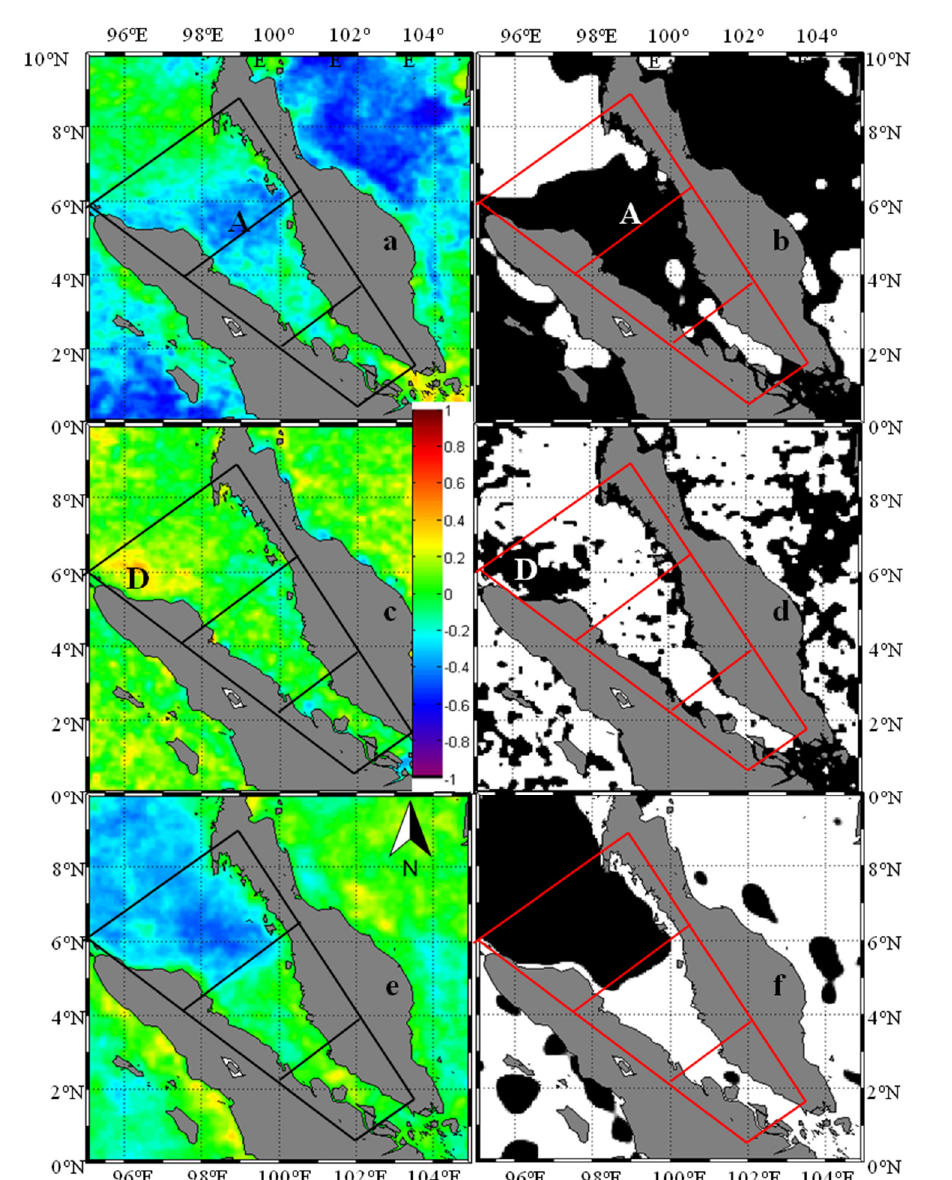
Figure 5. Spatial variations of the correlation coefficient ( r ) and corresponding p -value ( p ) derived from linear regressions of SeaWiFS chlorophyll- a concentration (Chl- a ) on ( a , b ) AVHRR/MODIS sea surface temperature (SST); ( c , d ) SeaWiFS aerosol optical thickness (AOT); and ( e , f ) TRMM rain rate. Black areas in panels (b,d,f) denote the regions of r with p < 0.05, the indication being that the correlation was significant. The letter A in (a) and (b) indicates the area with significant negative correlation between Chl- a and SST, whereas the letter D in (c) and (d) indicates the area where there was a significant positive correlation between Chl- a and